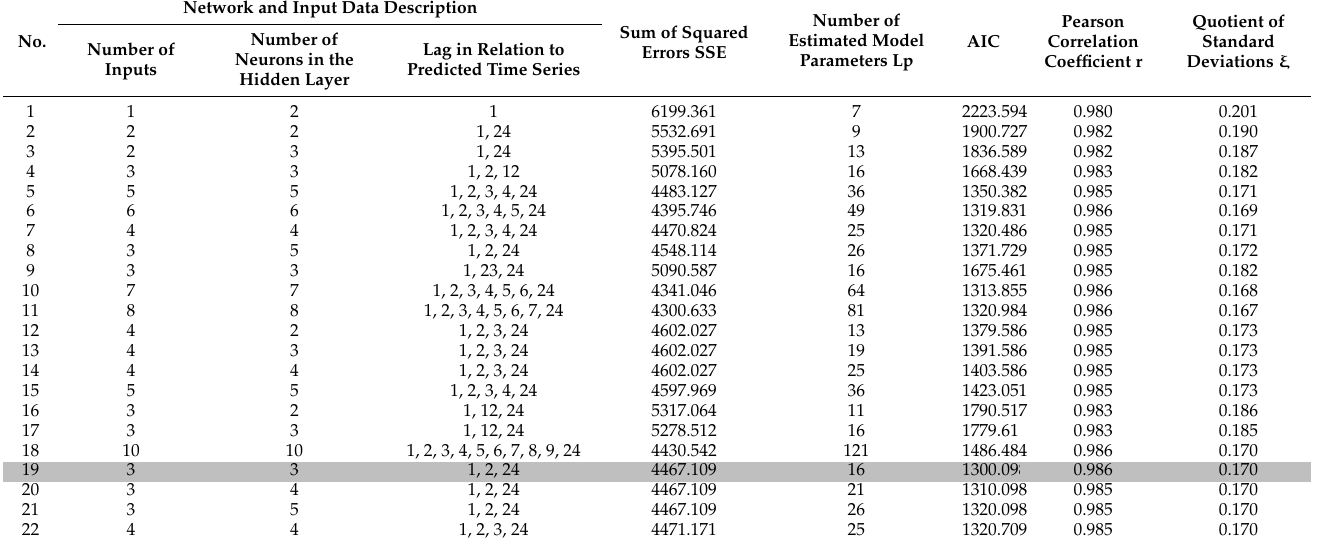
Table 1. Prediction results for MLP models.